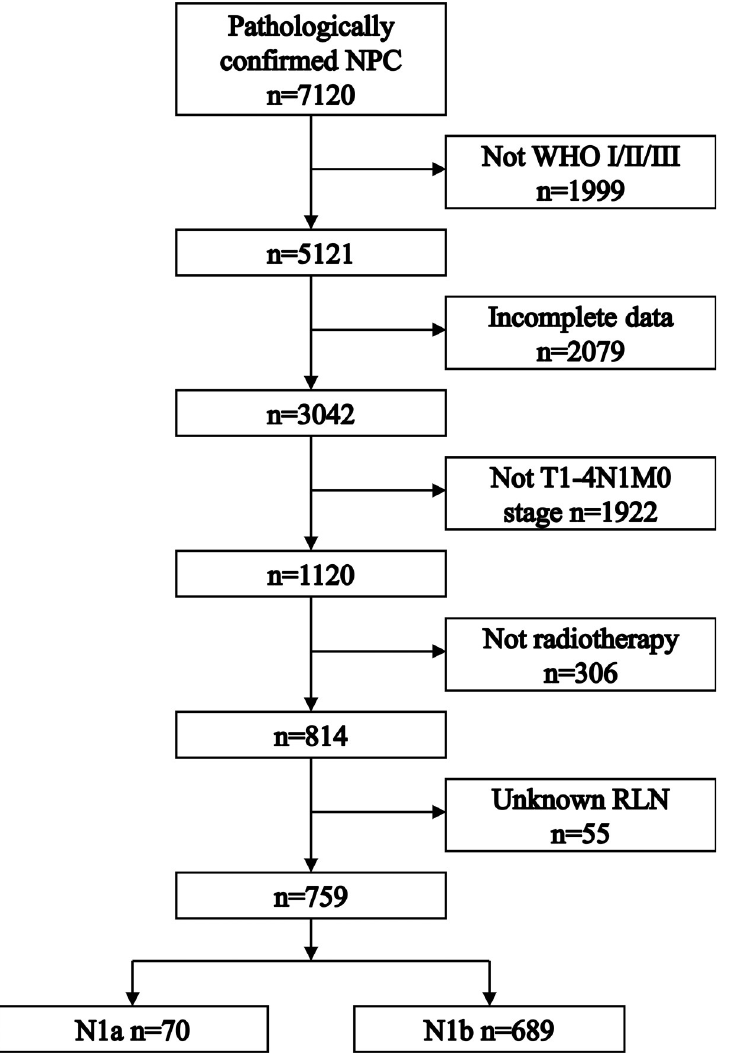
Fig 1. Flowchart depicting patient